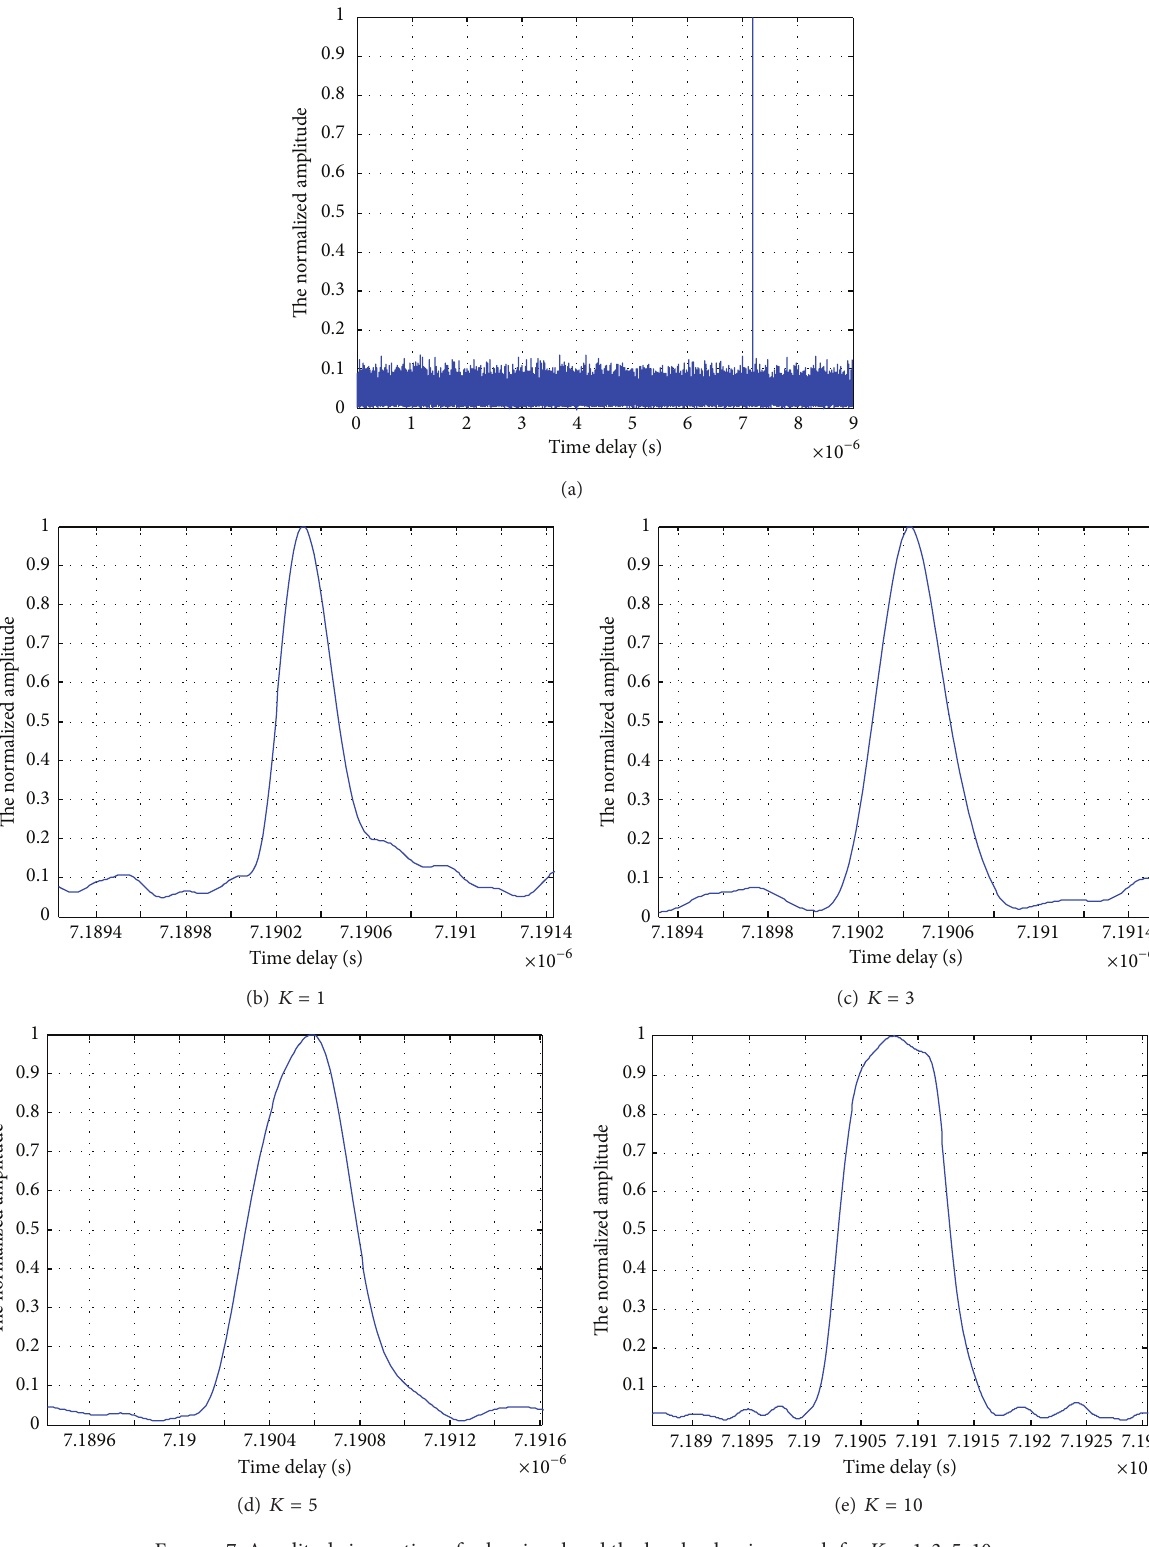
Figure 7: Amplitude impacting of echo signal and the local enlarging graph for 𝐾 = 1, 3, 5, 10